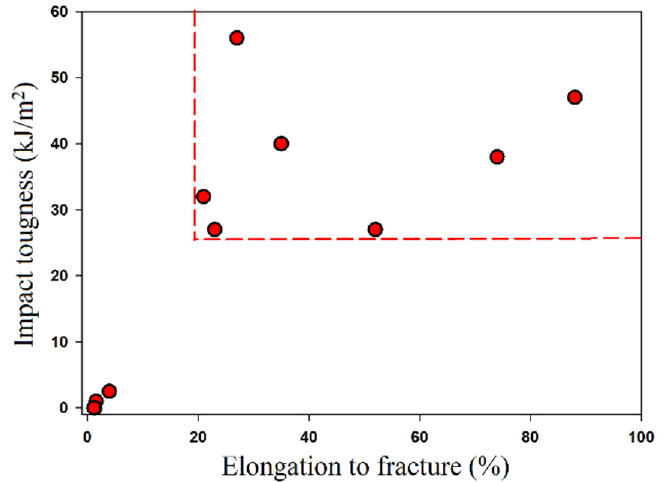
Figure 12. The relationship between the impact toughness and the elongation to fracture of the program alloys.